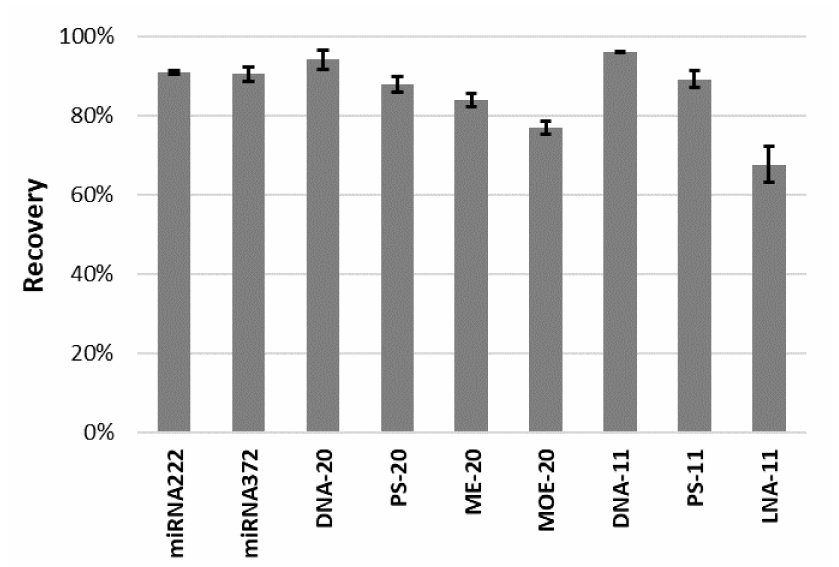
Figure 6. The recoveries obtained for the OGNs with different modification types and lengths in MDSPE with the use of MNP-Ac (extraction conditions in Table